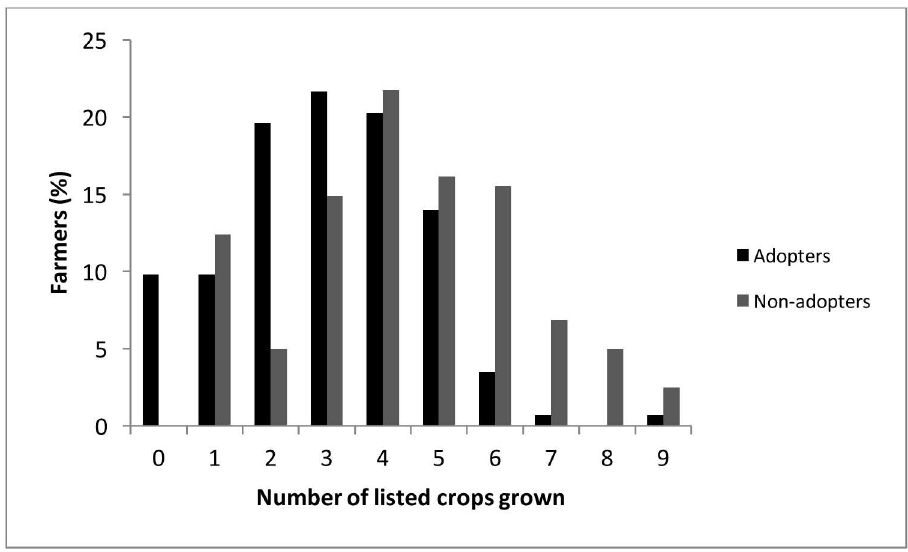
Fig 2. Crop diversity of CT adopters and non-adopters as shown by the number of crops grown.